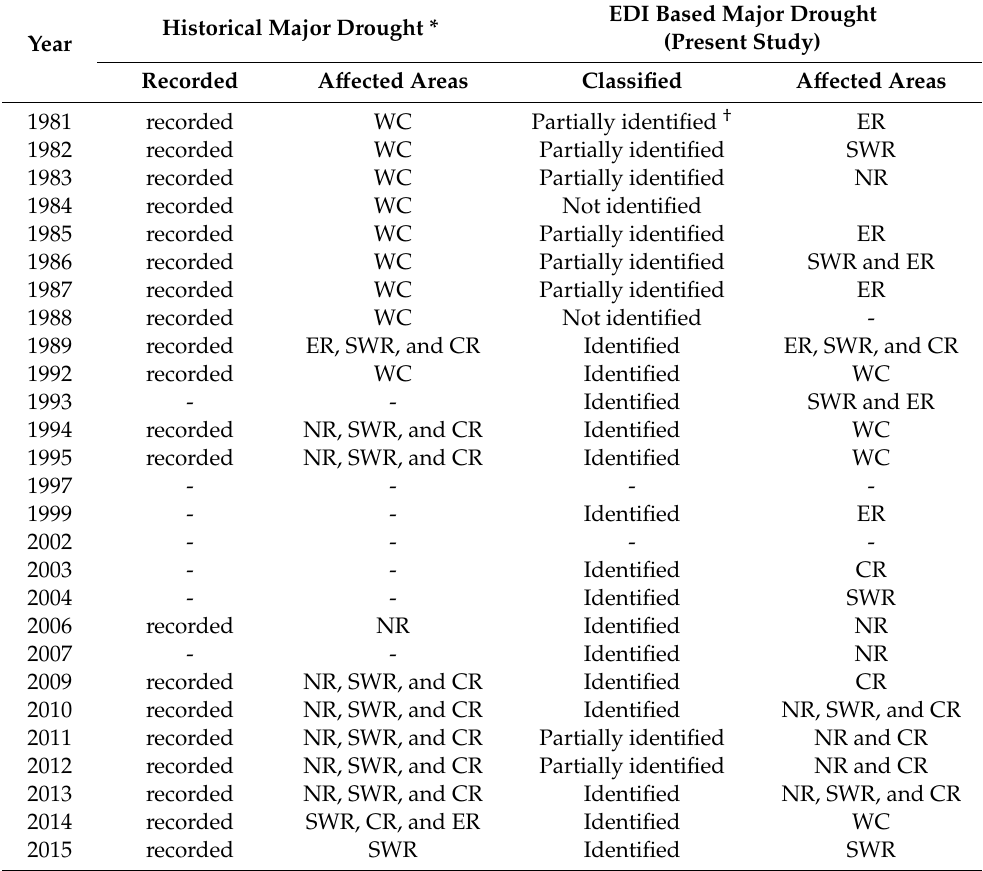
Table 1. Historical records of drought years and drought-a ff ected areas and the results of drought detection using the E ff ective Drought Index